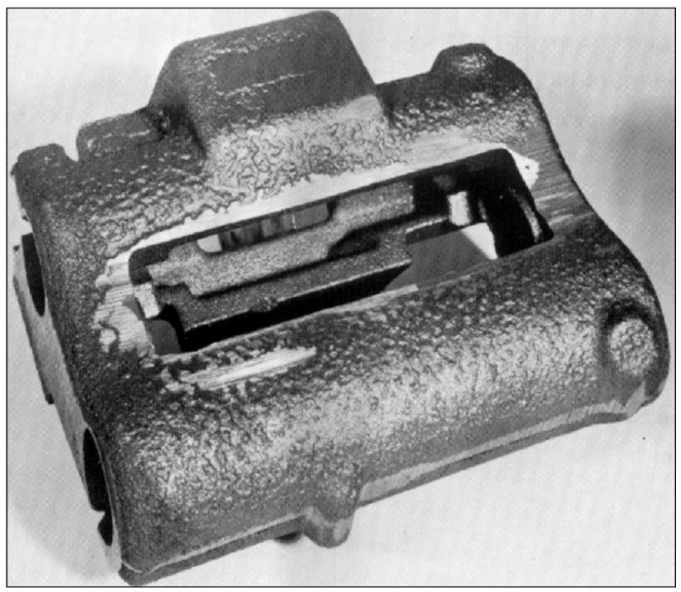
Figure 20. Vitrified surfaces in a malleable iron housing (Reprinted with permission from ref. [17]. Copyright 1999 American Foundry Society, page